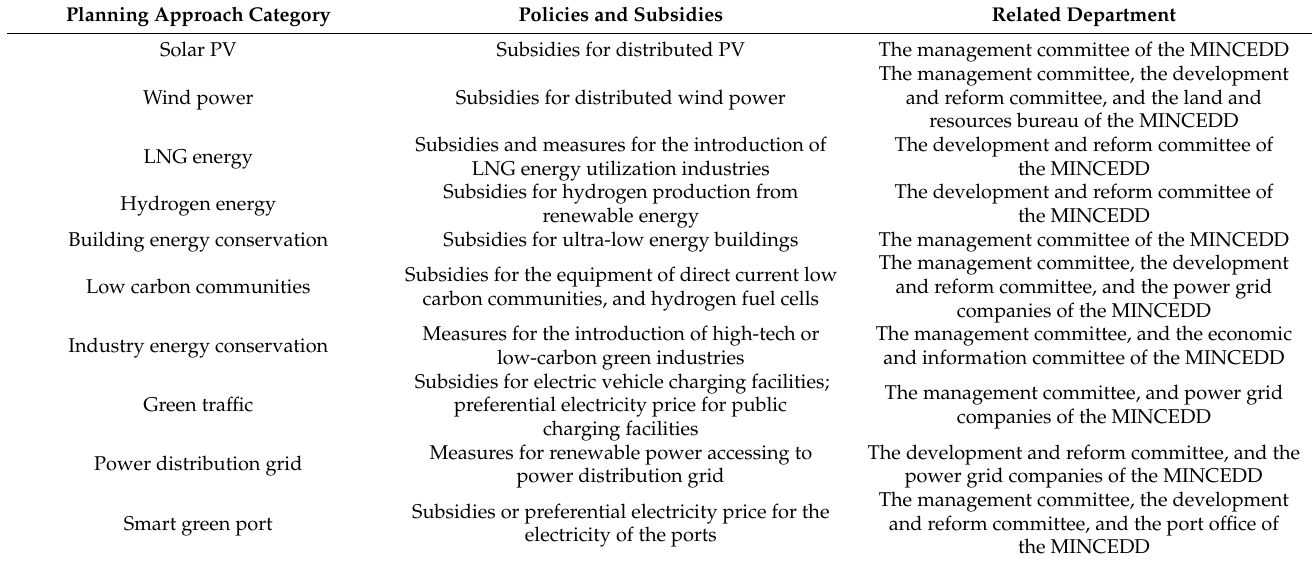
Table 15. The policies and subsidies for the planning scheme